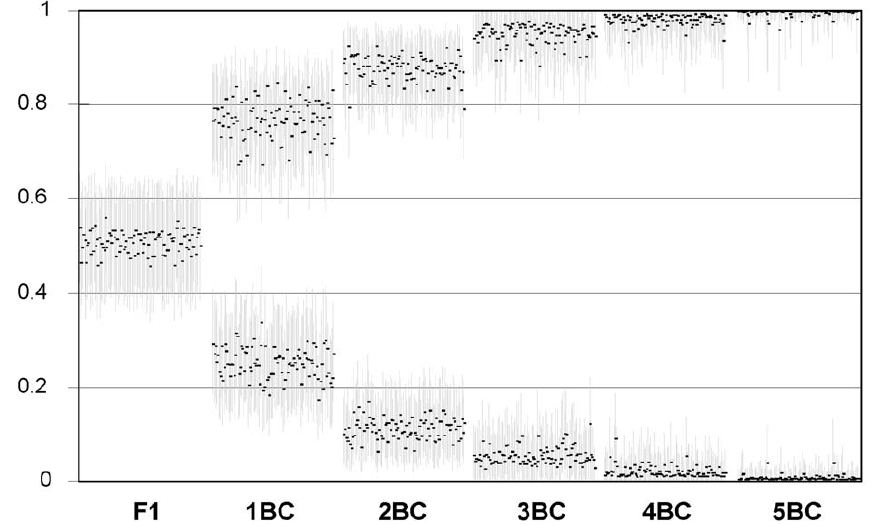
Figure 2. Admixture proportions and 90% credible regions to two genetic clusters of simulated hybrids (F1) and first–fifth generation backcrosses (1-5BC; 100 individuals in each category) between great reed warblers and clamorous reed warblers. The higher the admixture proportion, the higher the similarity to the genetic cluster corresponding to a ‘pure’ great reed warbler genotype.